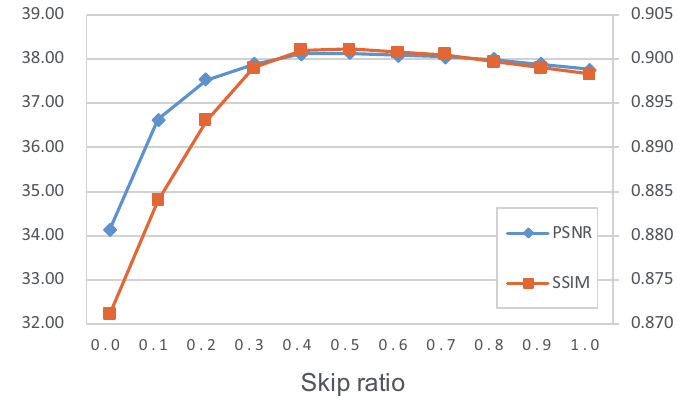
Figure 6. Trends of PSNR and SSIM with the skip ratio changing during testing on the